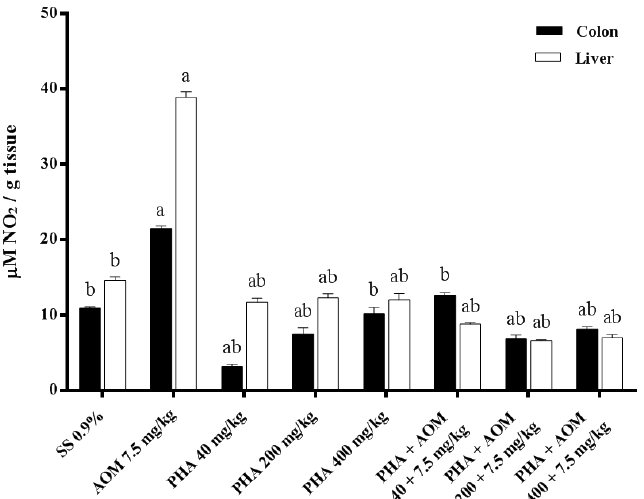
Figure 4. Effect of phaseolin (PHA) on the nitrite content (NO 2 ) in the colon and liver of mice administered azoxymethane (AOM). Each bar represents the mean ± SEM obtained from six mice per group. a Statistically significant difference with respect to the saline solution (SS) control group, and b with respect to the value obtained in the AOM-treated group. ANOVA and Holm-Šídák tests, p < 0.05.